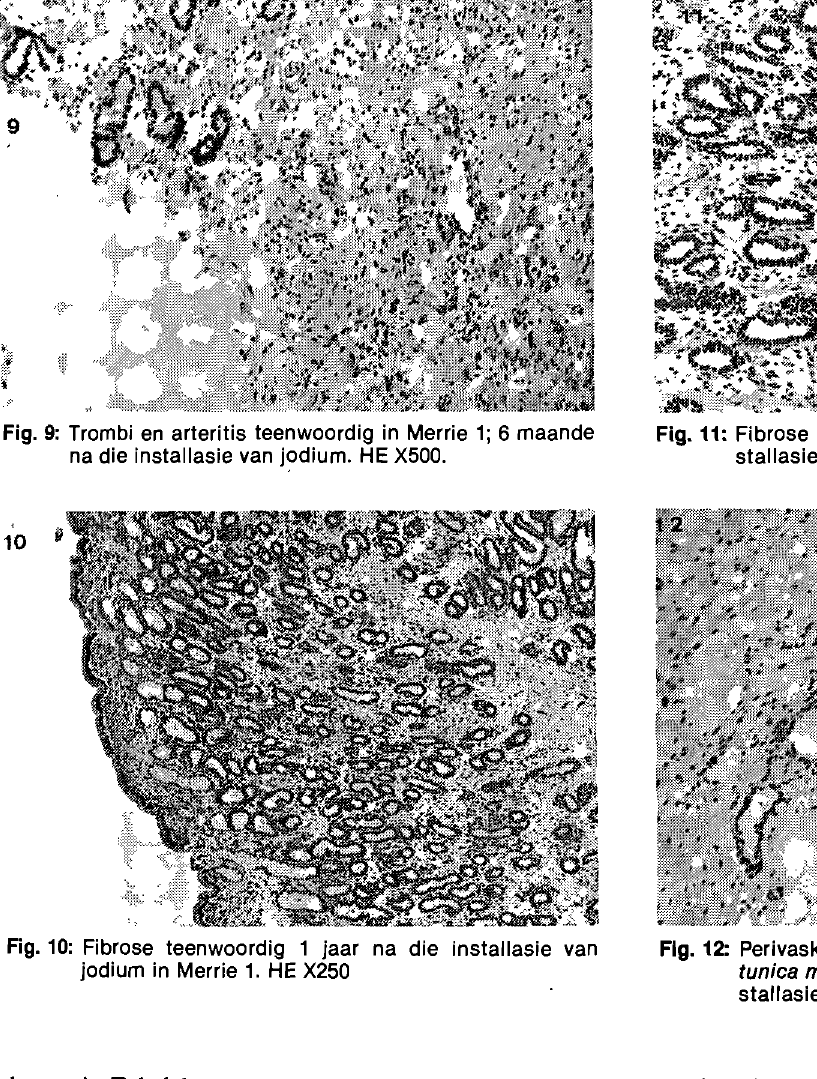
Fig. 12: Perivaskulere infiltrasle van 'n vena en edeem van die tunica media van die arterie. Merrie 1; 7 dae na die In· stallasie van jodium. HE